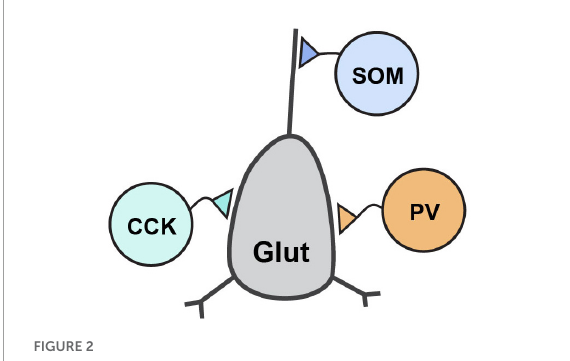
FIGURE2 Inhibitory interneuron connectivity. Simplified diagram of the prominent forebrain inhibitory interneuron types discussed in this review and their connectivity with a post-synaptic glutamatergic